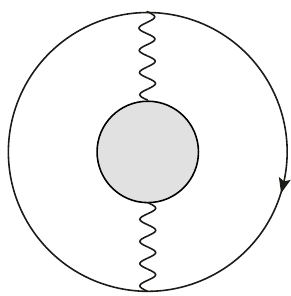
Figure 2 . This diagram illustrates how a CP-violating non-colored sector can contribute to (cid:22) (cid:18) via gauge loops. The grey blob refers to loops of colorless particles, the wavy lines are gauge bosons, and the outer solid line is a colored fermion (quark or messenger). By cutting the external solid line and attaching a Higgs or a mass if necessary, as well as an external (cid:24) to the blob, the diagram renormalizes the colored fermion mass, and hence (cid:22) (cid:18) . Alternatively, by attaching gluons to the solid line, the graph becomes a direct contribution to (cid:18) QCD (see, e.g.,